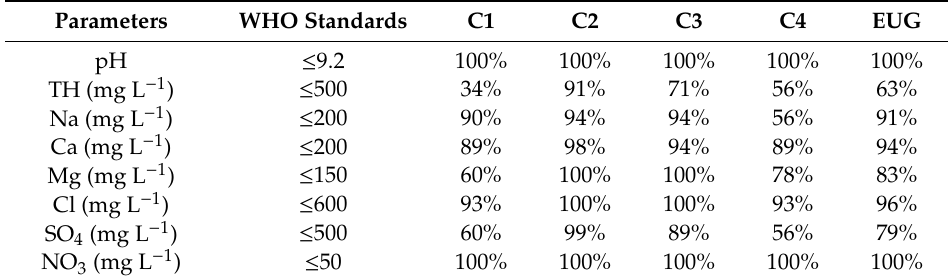
Table 6. Groundwater samples of the EUG basin below the permissible limits prescribed by WHO. For drinking